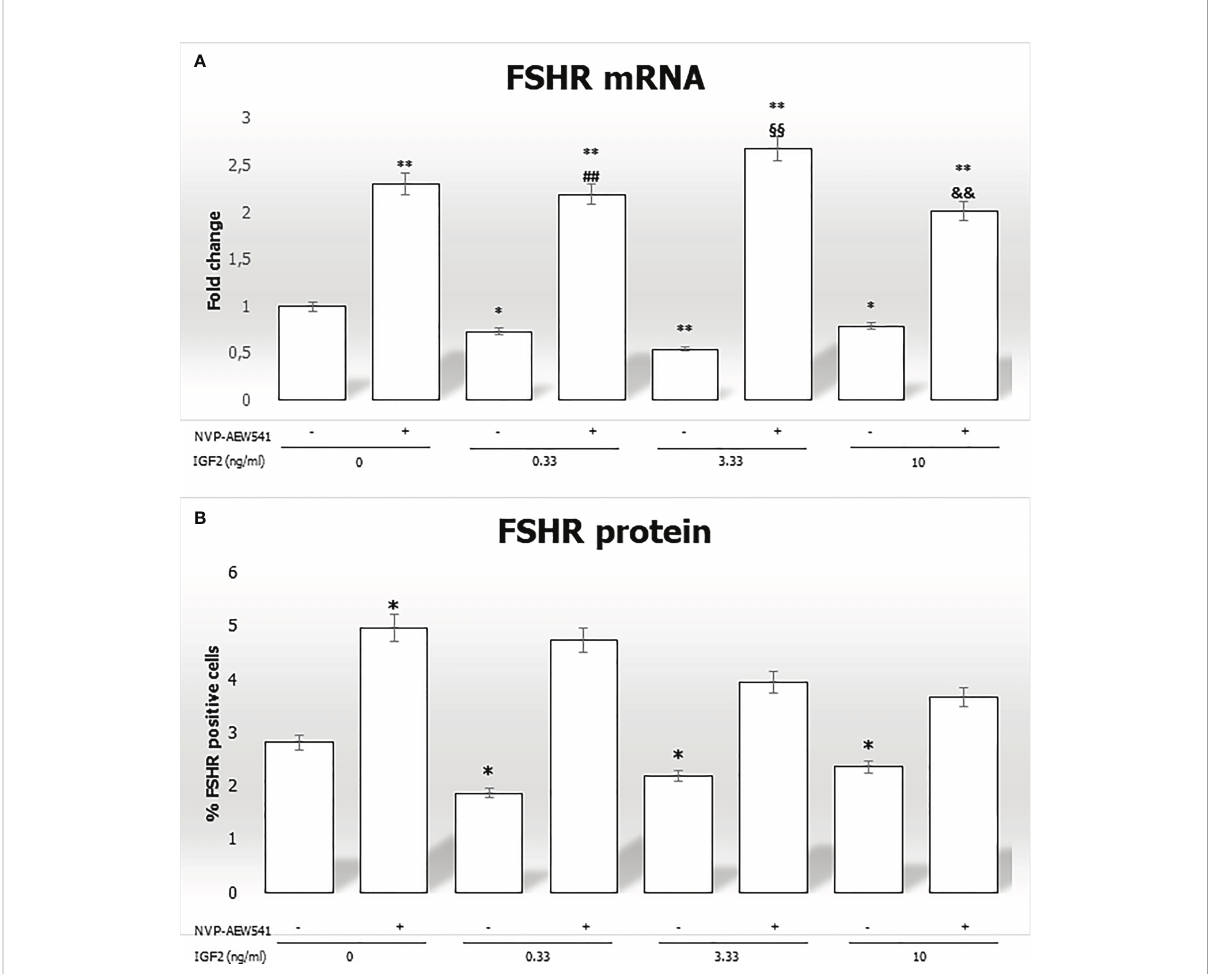
FIGURE 5 FSHR gene and protein expression in Sertoli cells (SCs). (A) RT-PCR analysis of the FSHR gene. Data represent the mean ± SD of three independent Q3 experiments, each performed in triplicate. (B) Cyto fl uorimetric analysis. The bars represent the percentage of FSHR-positive cells without stimulation, after incubation with NVP-AEW541, IGF2, or NVP-AEW541 + IGF2. Compared with the control, the percentage of FSHR-positive cells was signi fi cantly reduced after incubation with IGF2 (2.82 ± 0.1% in the untreated controls, 1.87 ± 0.1% at 0.33 ng/mL, 2.19 ± 0.2% at 3.33 ng/mL, 2.36 ± 0.1% at 10 ng/mL; p < 0.01). The suppression was reversed after incubation with NVP- AEW541. Data represent the mean ± SD of three independent experiments, each performed in triplicate. FSHR, follicle-stimulating hormone receptor; IGF2, Insulin-like growth factor 2. *p < 0.05 and **p < 0.001 vs SCs, ##p < 0.001 vs 0.33 ng/ml of rhIGF2, §§p < 0.001 vs 3.33 ng/ml, &&p < 0.001 vs 10 ng/ml of rhIGF2